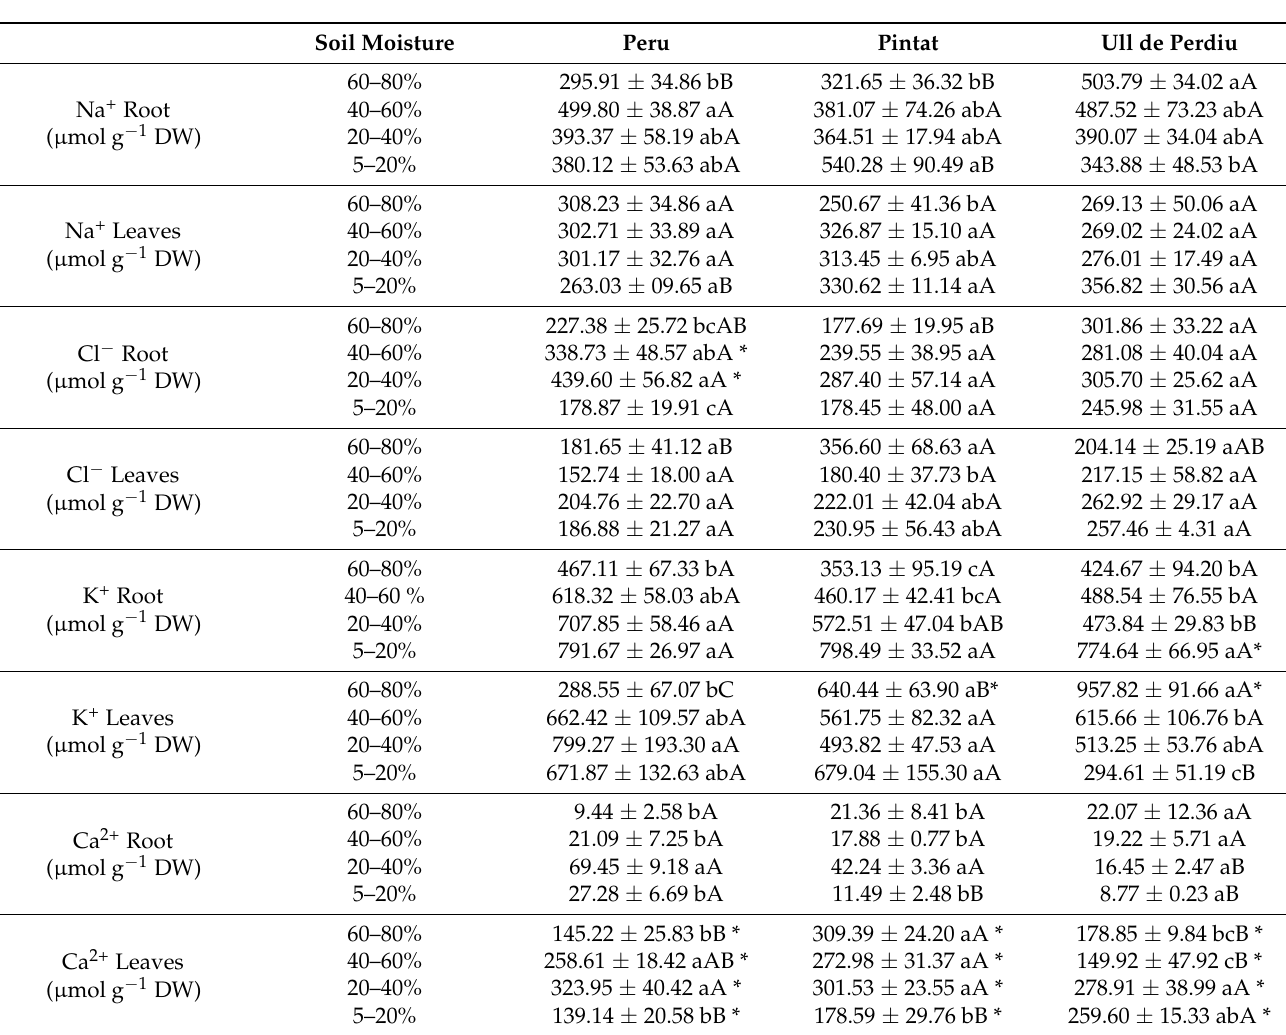
Table 1. Root and leaf contents of sodium (Na + ), chloride (Cl − ), potassium (K + ) and calcium (Ca 2+ ) in plants of the three Phaseolus lunatus cultivars. Lowercase letters indicate significant differences within each cultivar, uppercase letters (in bold) between cultivars within treatments and asterisk (*) between roots and leaves within treatments and cultivars according to Tukey’s test ( α = 0.05). p values according to one-way